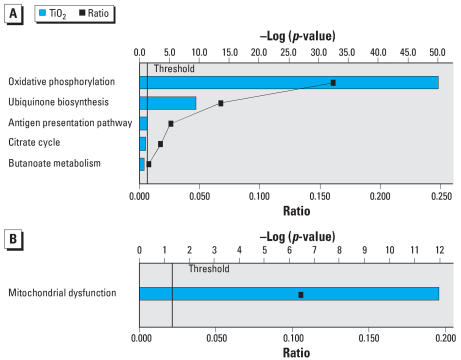
BV2 microglia were exposed to P25 (20 ppm) for 3 hr. (A) Canonical analysis of all P25 affected genes associated with OS indicated that they largely clustered around key energy pathways involving oxidative phosphorylation, biosynthesis of ubiquinone (involved in shuttling electrons in the ETC) and the citric acid cycle. (B) Toxicity Pathway analysis localized these pathways further to mitochondrial dysfunction.